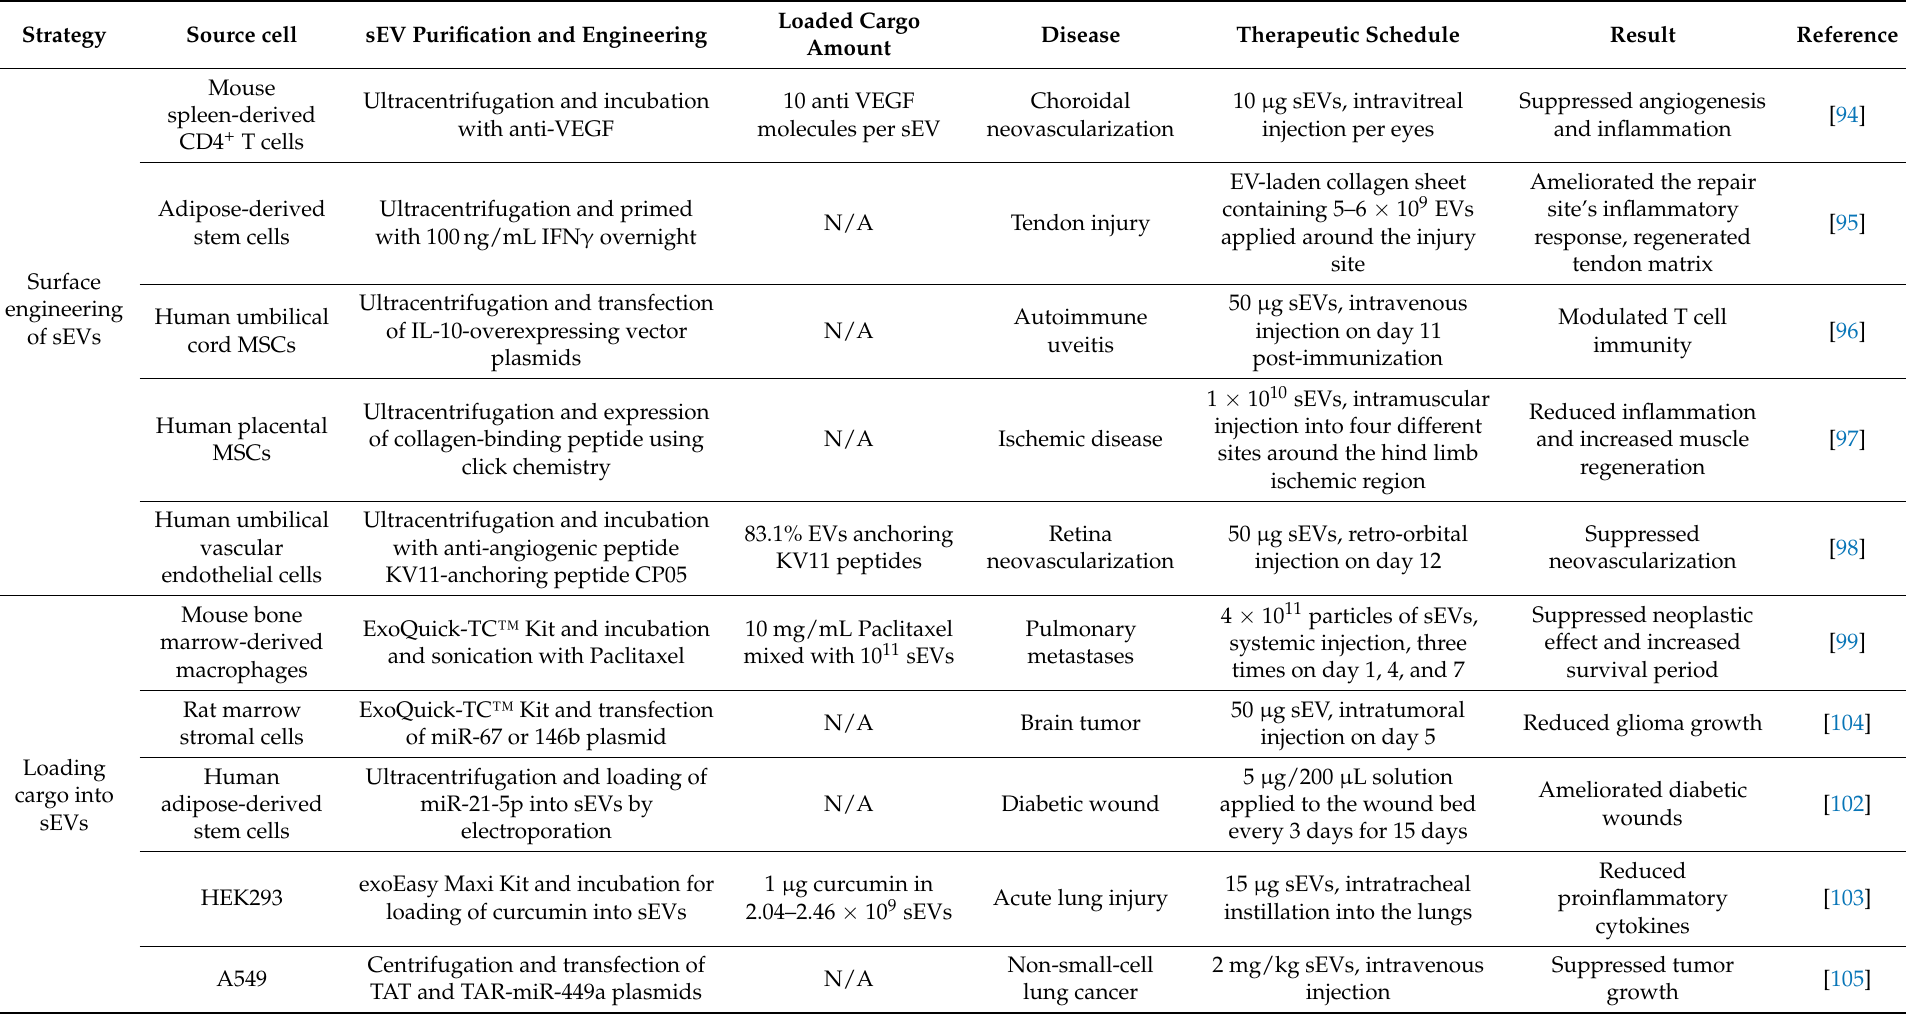
Table 4. Therapeutics using engineered